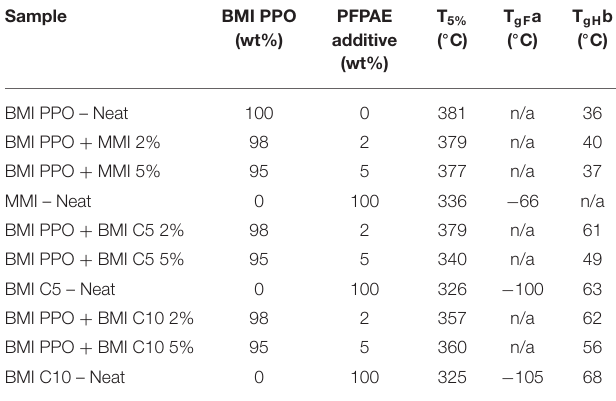
Frontiers in Materials |